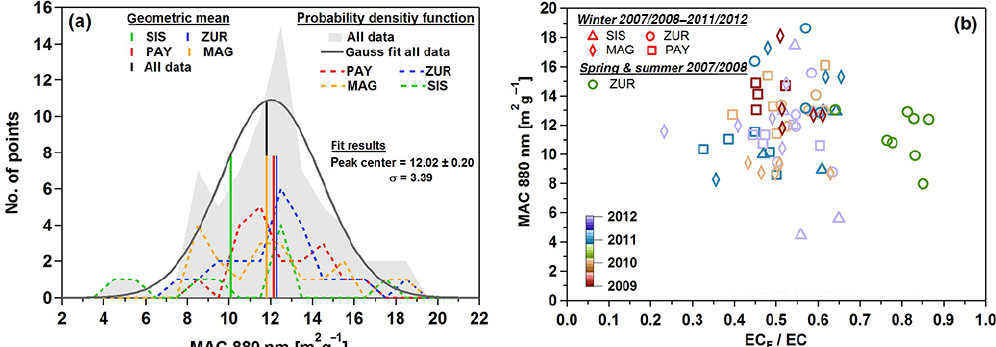
Figure 2. Distribution of MAC values of EBC at 880nm (a) and comparison with the fossil fraction of EC (EC F / EC) determined with the 14 C analysis (b) . MAC values were determined assuming a C value of 2.14 for the Aethalometer and the EUSAAR-2 thermal optical trans- mission protocol was used for EC mass measurement. Only data from the 14 C project Switzerland are included, since in earlier campaigns EC concentrations were not determined or measured with the same TOT